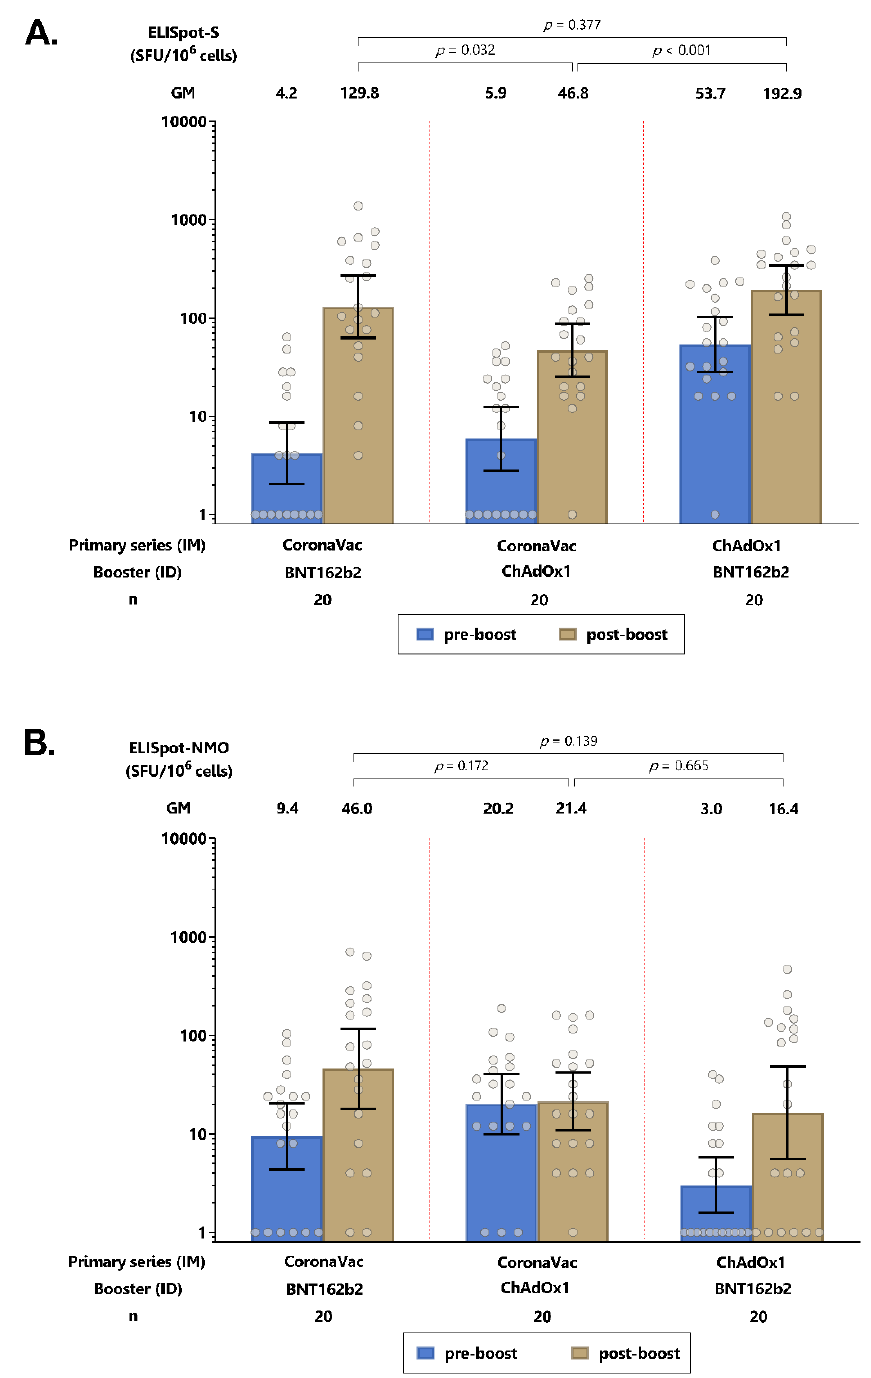
Figure 4. SARS-CoV-2 antigen-specific T-cell response by ELISPOT after intradermal (ID) booster. ( A ) Spike-specific T cell responses. ( B ) Nucleocapsid-membrane-open reading frame-T cell responses. Error bars represent geometric mean concentrations plus 95% confidence intervals. SFU: spot- forming